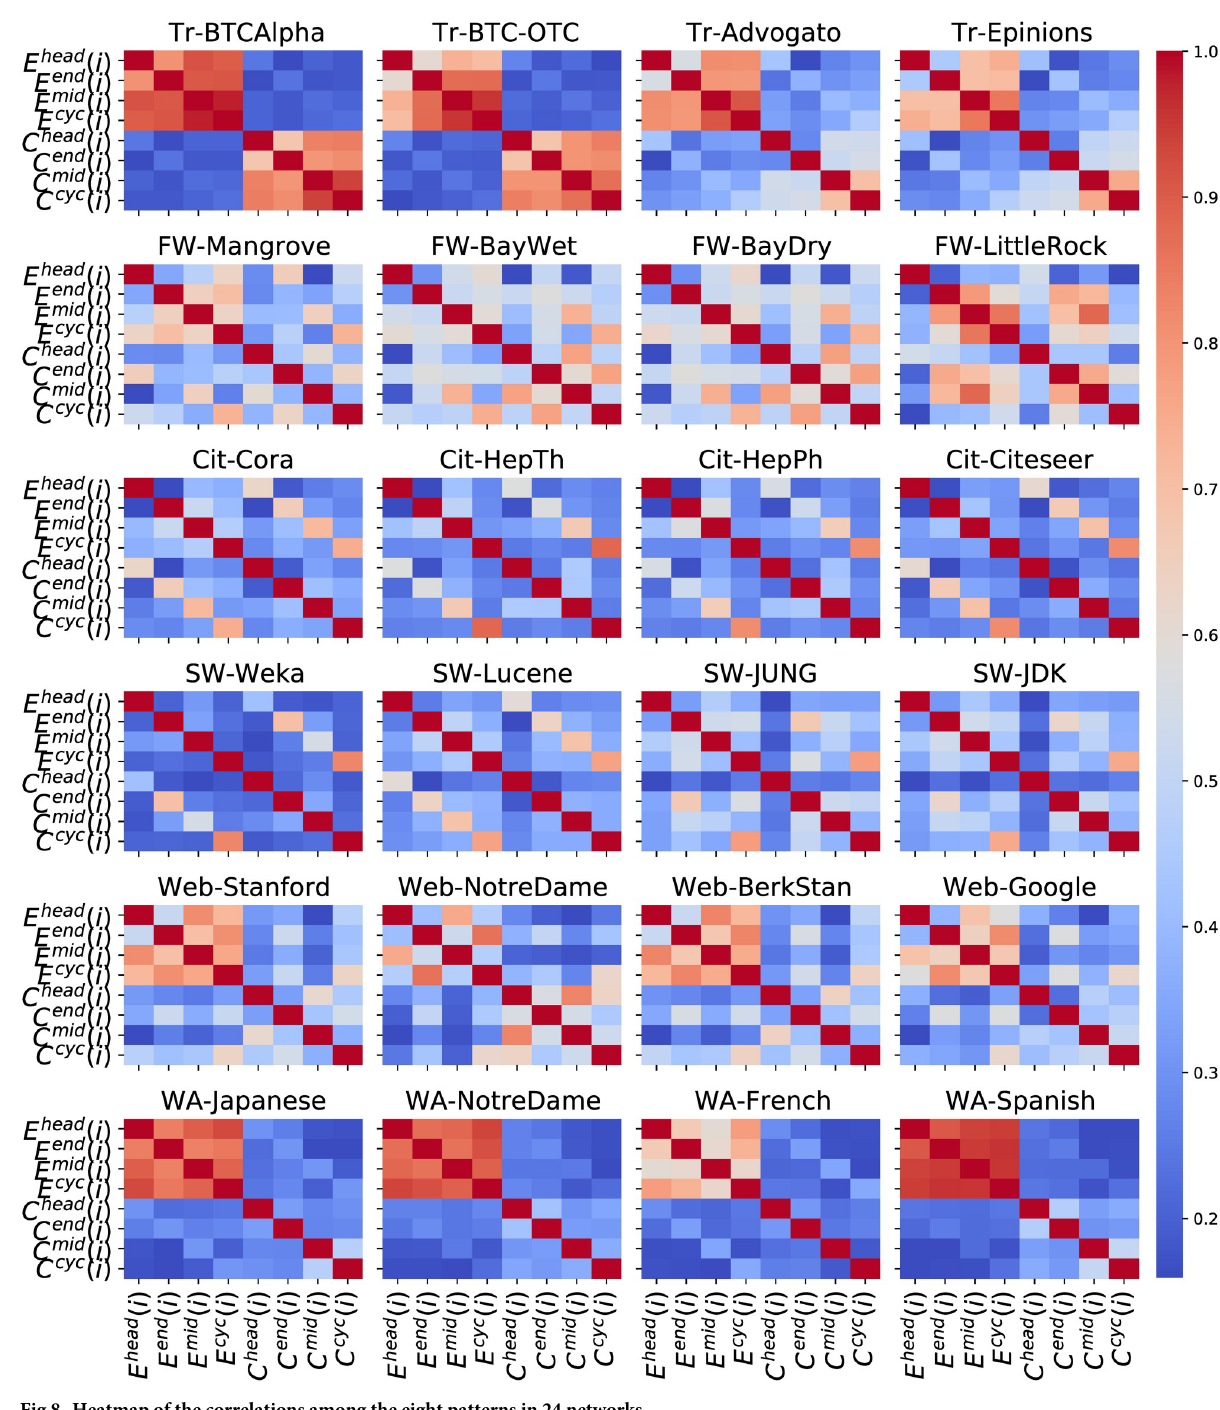
Fig 8. Heatmap of the correlations among the eight patterns in 24 networks.